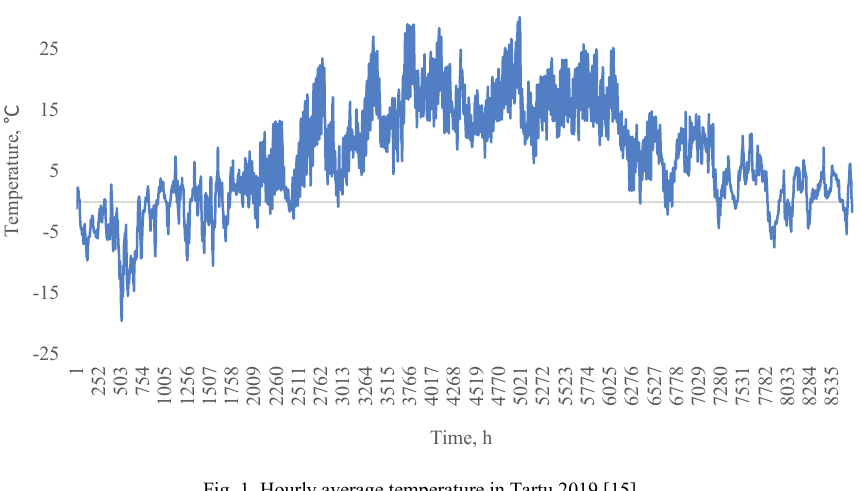
Fig. 1. Hourly average temperature in Tartu 2019